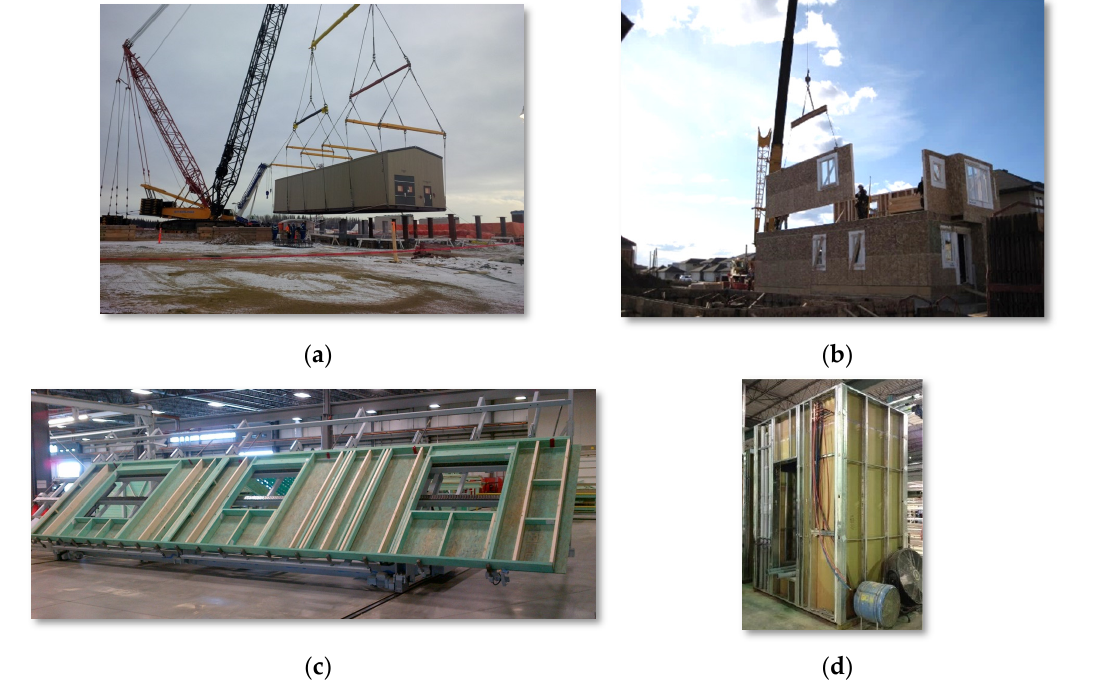
Figure 2. Typical off-site construction examples: ( a ) Heavy industrial module installation, ( b ) Wood panelized residential construction, ( c ) Wood panel manufacturing, and ( d ) Light-gauge-steel bath- room pods.